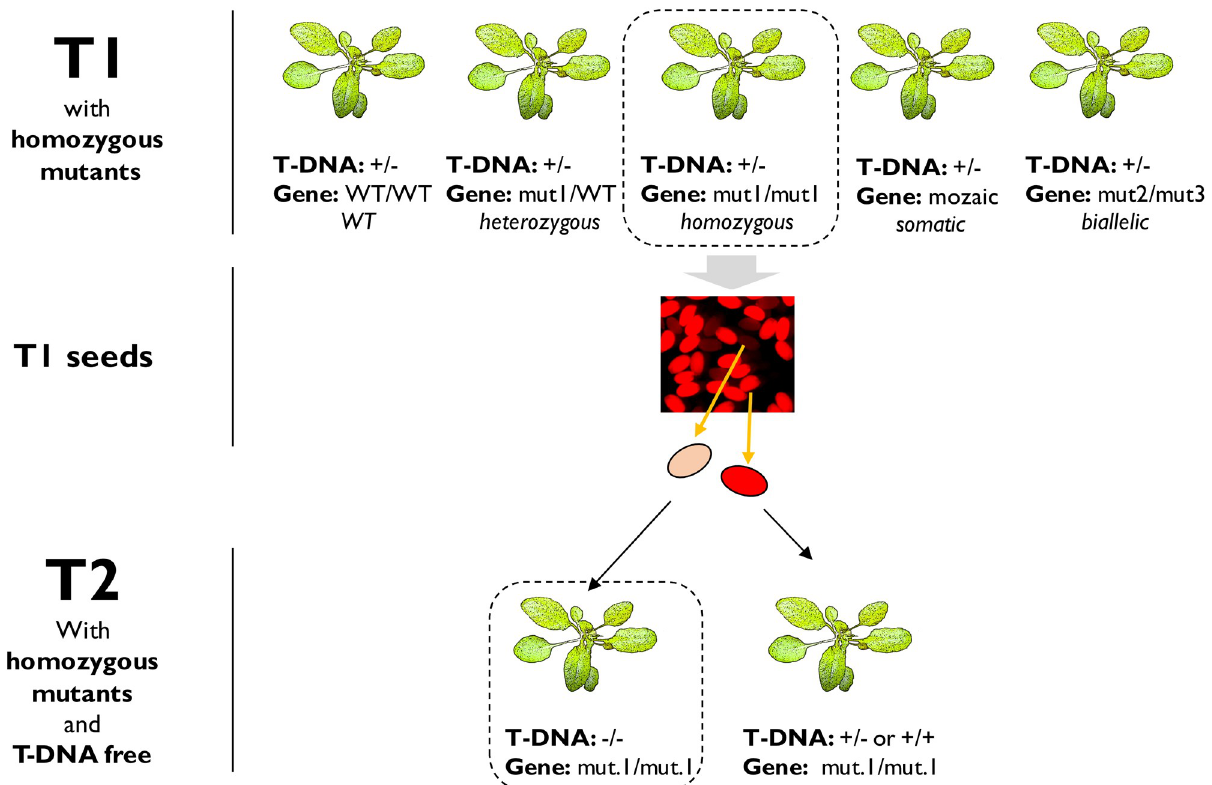
Fig 10. FAST-Red combined with CRISPR to generate T-DNA free mutants. The five T1 lines are independent transformants. They are all hemizygous for the T-DNA. At the sgRNA target site, they can be WT, or display somatic, heterozygous, biallelic of homozygous mutations. All the possibilities are represented here. “Somatic” describes events happening in somatic cells, not inherited in the next generation. As somatic events can happen independently in each cell, they often result in mosaic pattern of mutations across the leaf. One line has homozygous mutation ( mut1/mut1 ). It produces seeds segregating for the T-DNA, visible under microscope if using FAST-Red. The seeds will segregate 3:1 (Red: Non-red) if there is one locus insertion, 15:1 (Red: Non-red) if there are two loci insertion, etc. The T2 progeny of (mut1/mut1) is 100% homozygous for the mutation. The non-red seeds are also T-DNA